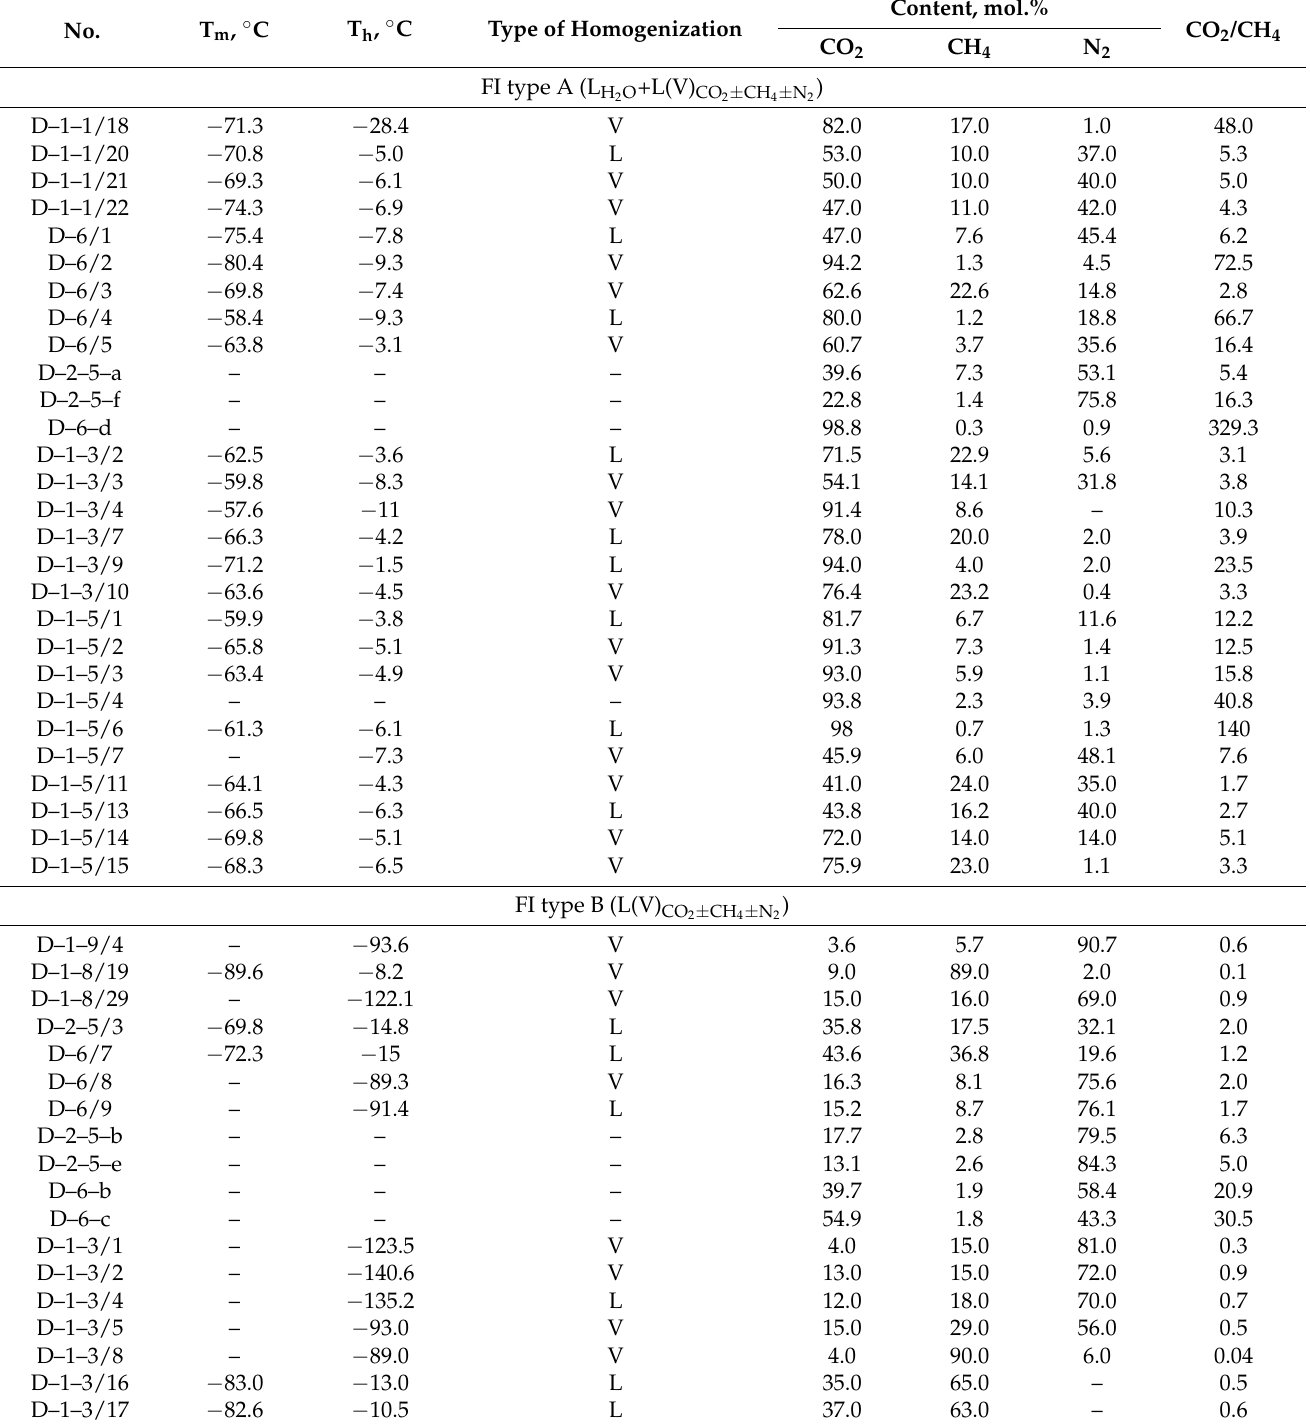
Table 2. Microthermometric characteristics and compositions of the gas phases of individual pri- mary and pseudosecondary fluid inclusions in quartz of the Dobroe gold deposit (Raman spec- troscopy